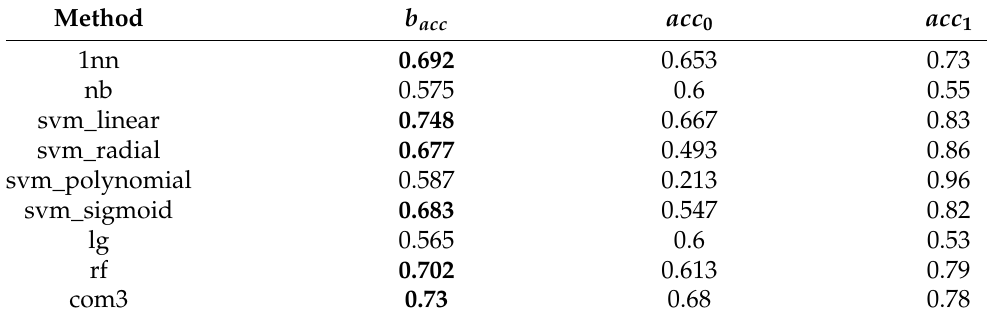
Table 6. Summary of results for data.bee1.2 with baseline correction.